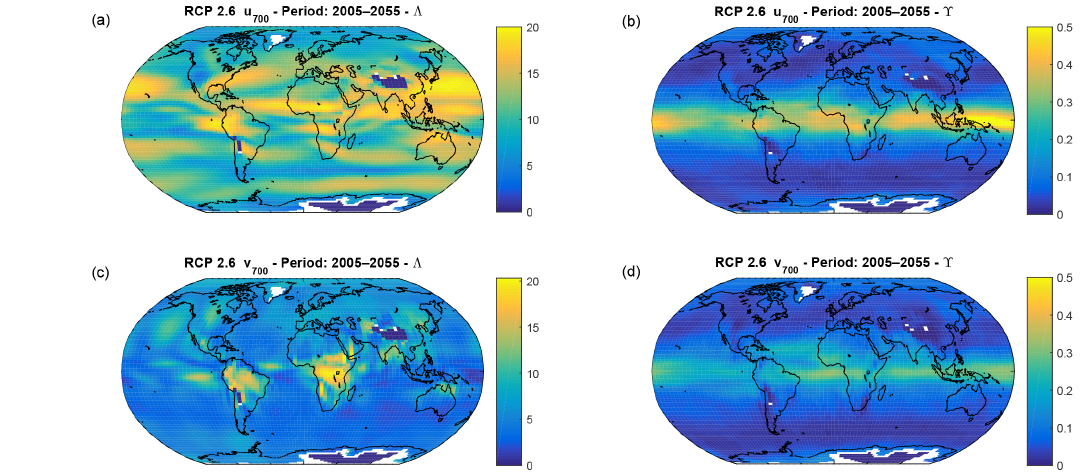
Figure 2. Integral of the autocorrelation function (cid:51) for the period 2005–2055 for the u 700 (a) and for the v 700 (c) daily time series. Spectral complexity ϒ for the period 2005–2055 for the u 700 (b) and for the v 700 (d) daily time